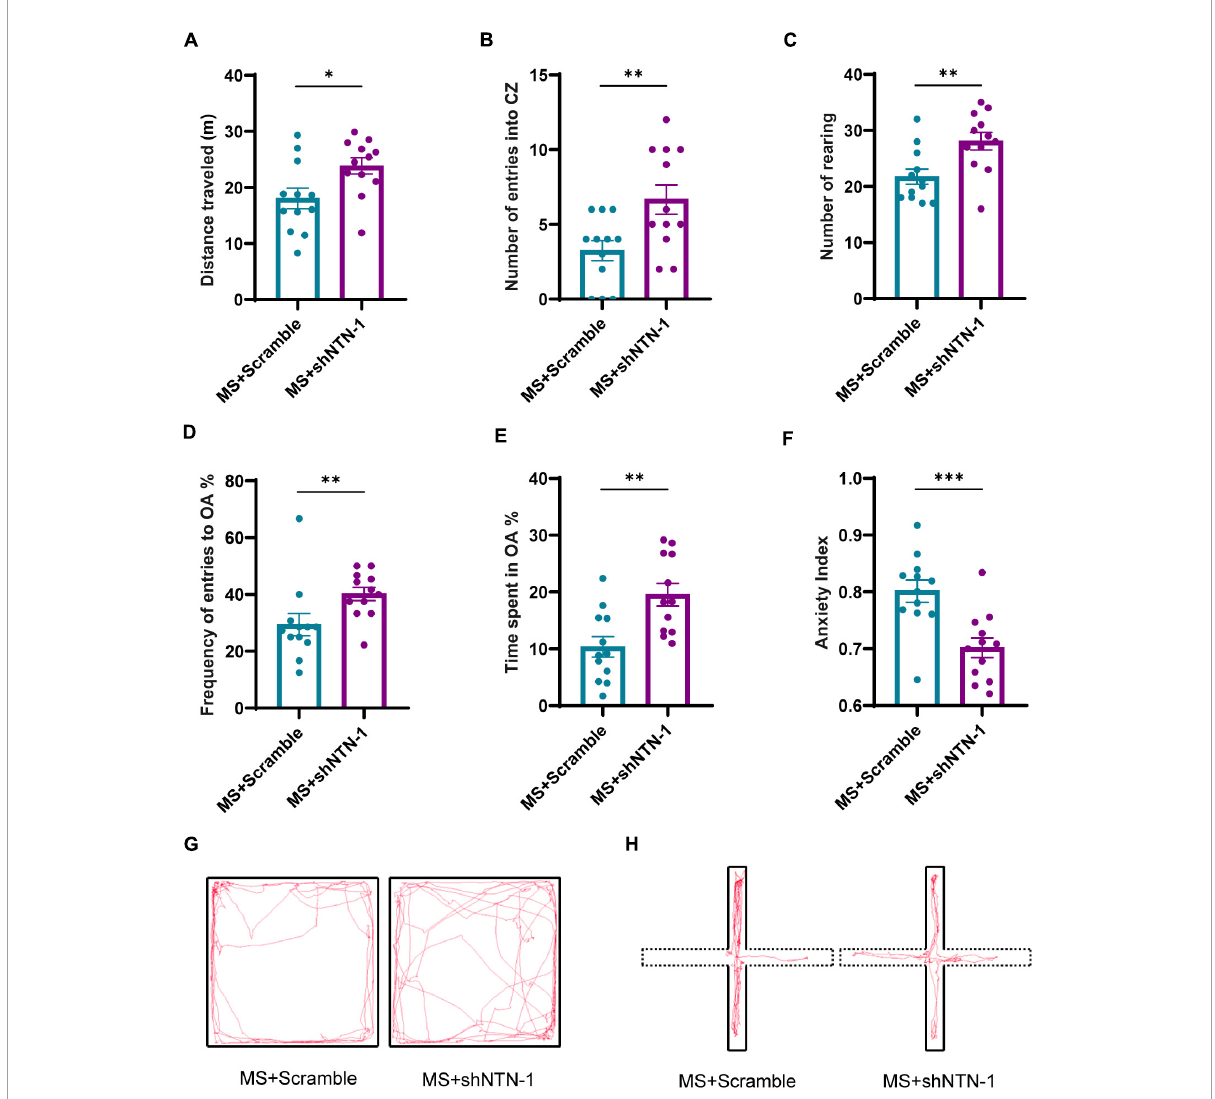
FIGURE8 Knockdown of Netrin-1 (NTN-1) in hippocampal CA1 regions reversed the increase of anxiety-like behaviors caused by MS. (A) In OFT, compared with rats injected Lenti-Scramble (MS + Scramble), rats expressing Lenti-shNTN-1 (MS + shNTN-1) showed longer distance traveled, (B) more entries into the center zone, and (C) more rearing. (D) In the EPM test, the percentage of numbers of entries into OA and (E) the percentage of time spent in OA in the MS + shNTN-1 group were significantly increased, and (F) the anxiety index was reduced significantly. (G) Representative animal track in the OFT and (H) EPM. MS + Scramble: n = 12. MS + shNTN1: n = 12. All data were given as mean ± SEM. ∗ P < 0.05, ∗∗ P < 0.01, ∗∗∗ P < 0.001, two-tailed unpaired Student’s t